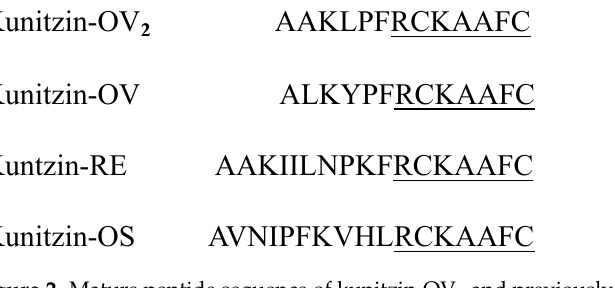
Figure 2. Mature peptide sequence of kunitzin-OV 2 and previously published kunitzin peptides [10,11]. Fully conserved domains are single-underlined.